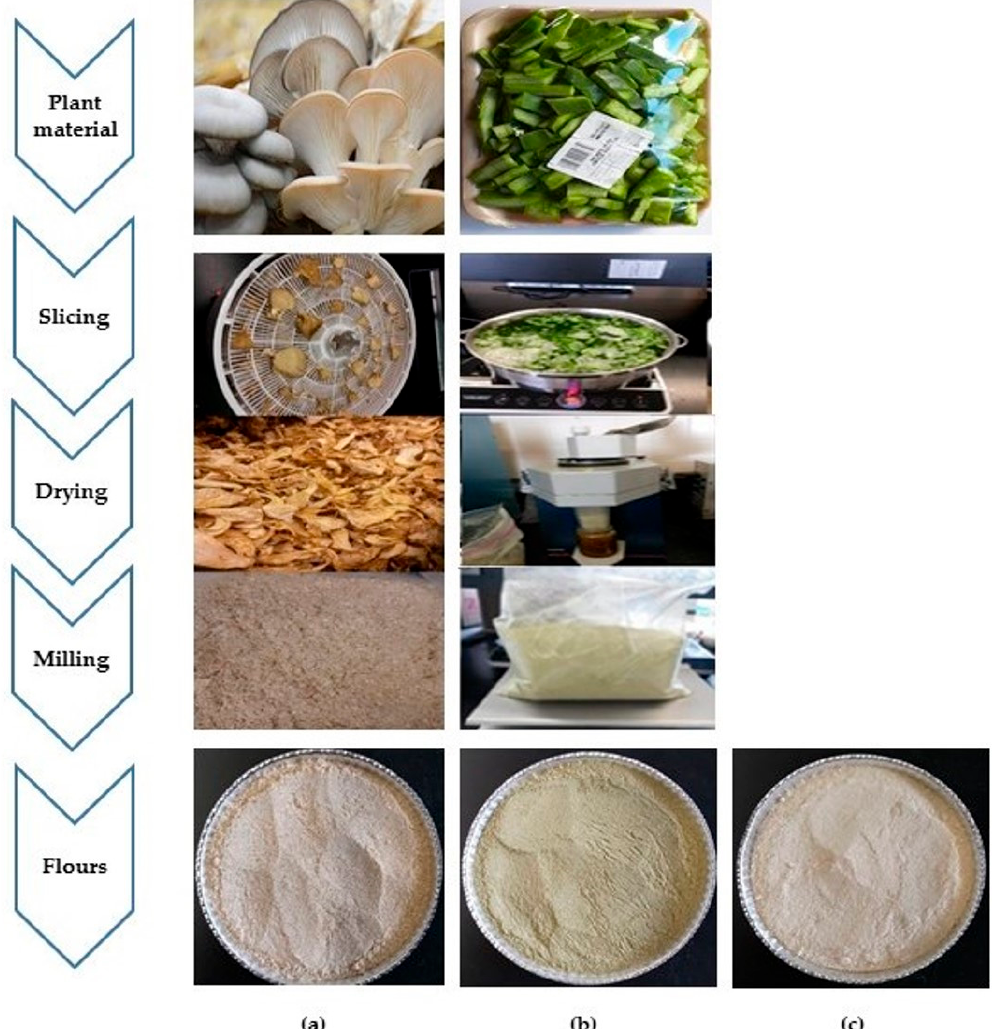
Figure 1. Plant material and its processing for biofunctional flour preparation. ( a ) Pleurotus ostreatus (oyster mushroom); ( b ) Nopal ( Opuntia ficus-indica L.); ( c ) Amaranth ( Amaranthus sp.). Photographs of commercial oyster mushrooms and nopal were taken from the companies’ websites (Hongos El Dorado, Mexico and COLPOS, Texcoco, Mexico, for oyster mushrooms and nopal, respectively). Photographs of powder making and flours were taken by Prof. Marcos Meneses–Mayo from Universidad Anáhuac Mexico.